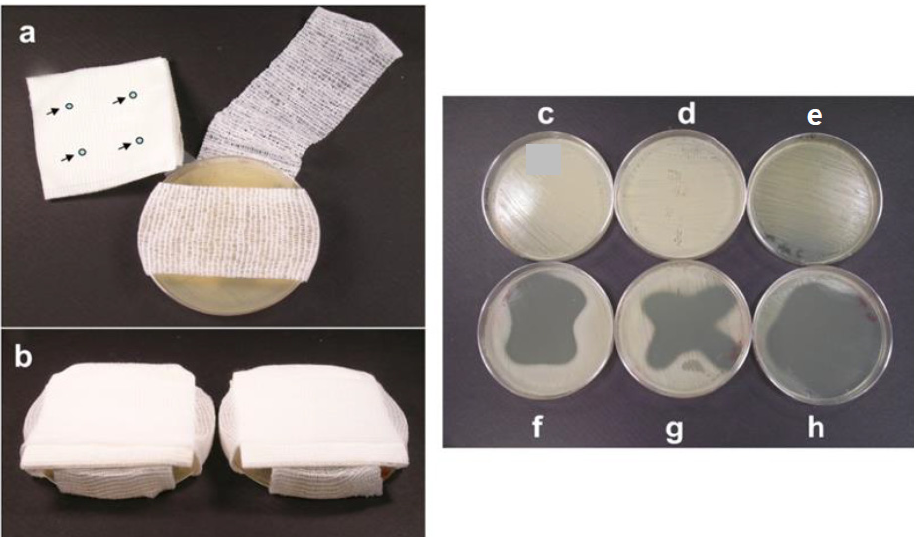
Figure 6. Dressing model using an agar plate. ( a ) arrows indicate the cold pressed Valencia orange oil spots on gauze dressing pad; ( b ) complete setup of dressing model with gauze dressing pad wrapped with bandage. Untreated control plates of bacterial strains S. aureus : ( c ) COL; ( d ) Mu50; and ( e ). Inhibition of S. aureus : ( f ) COL; ( g ) Mu50; and ( h ) caused by the cold pressed Valencia orange oil [191]. (Copyright BioMed Central